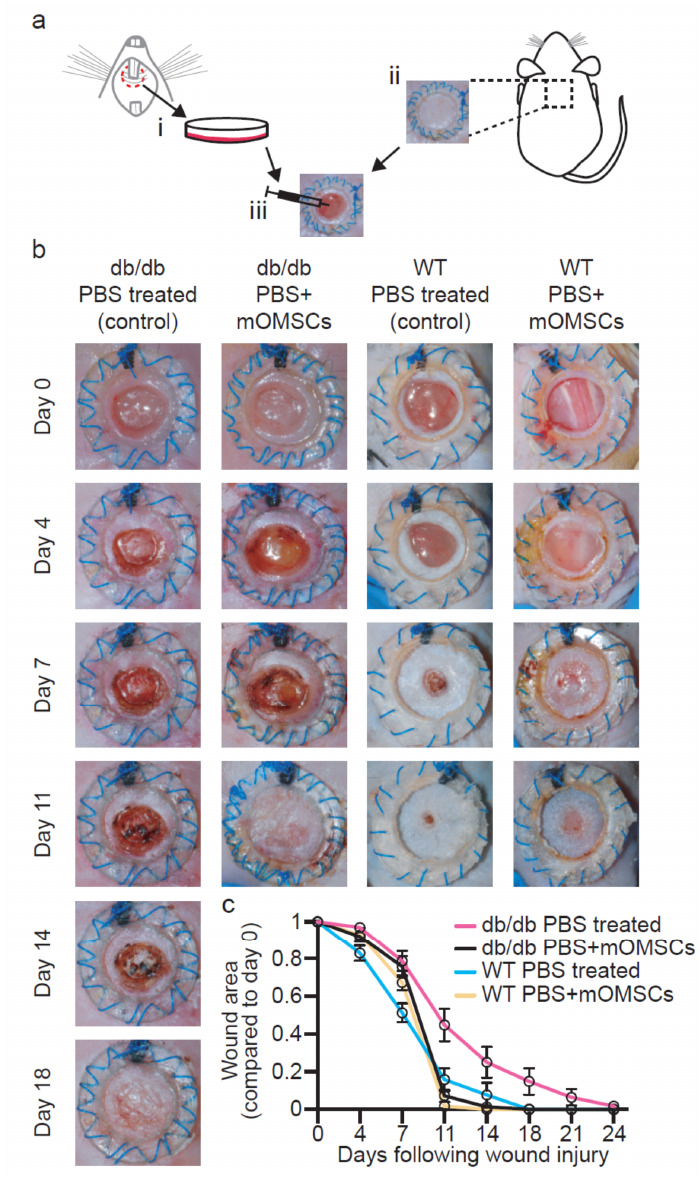
Figure 1. ( a ) Schematic drawing of wound-healing model for the evaluation of the therapeutic potential of mouse oral mucosa stem cells (mOMSCs). i. mOMSCs were isolated from oral mucosa tissue of healthy Balb / c mice. ii. Wound excision. iii. Oral mucosa stem cells of allogeneic Balb / c mice were injected around and under the wound. ( b ) Change in wound area. Digital photographs showing the change in the wound area over time in WT and db / db PBS + mOMSCs-treated and PBS-treated mice. ( c ) Kinetics of wound closure. Di ff erences in mean wound area of treated WT and db / db mice with Balb / c mOMSCs + PBS (yellow and black, respectively) and PBS-treated WT and db / db mice (blue and pink, respectively). Each point represents the mean of the percentage in area of the original wound size ± SEM ( p <